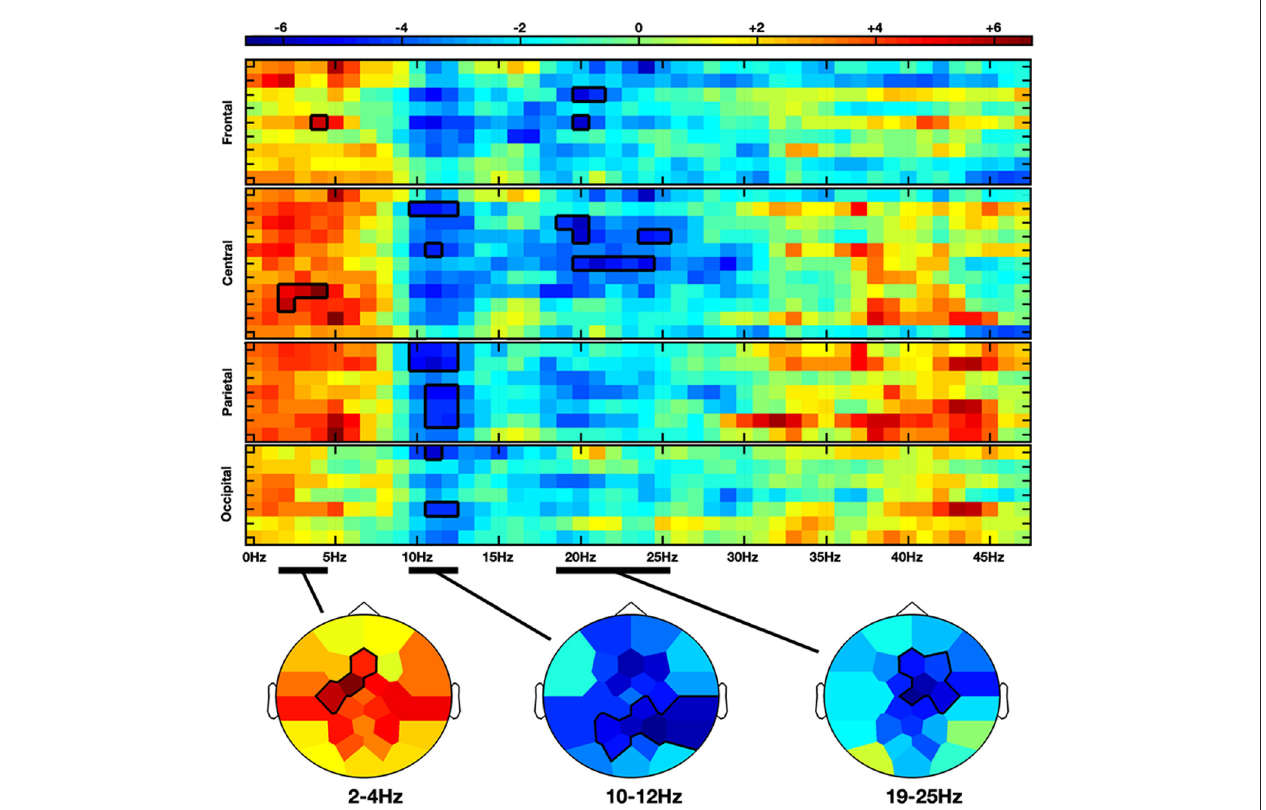
FIGURE 2 | Non-parametric clustering analysis applied to the NVM versus NVNM contrast. Rows and columns represent, respectively, electrodes and frequency bins. Electrodes are grouped by anatomical region. The color stands for the t -values calculated between the two conditions with